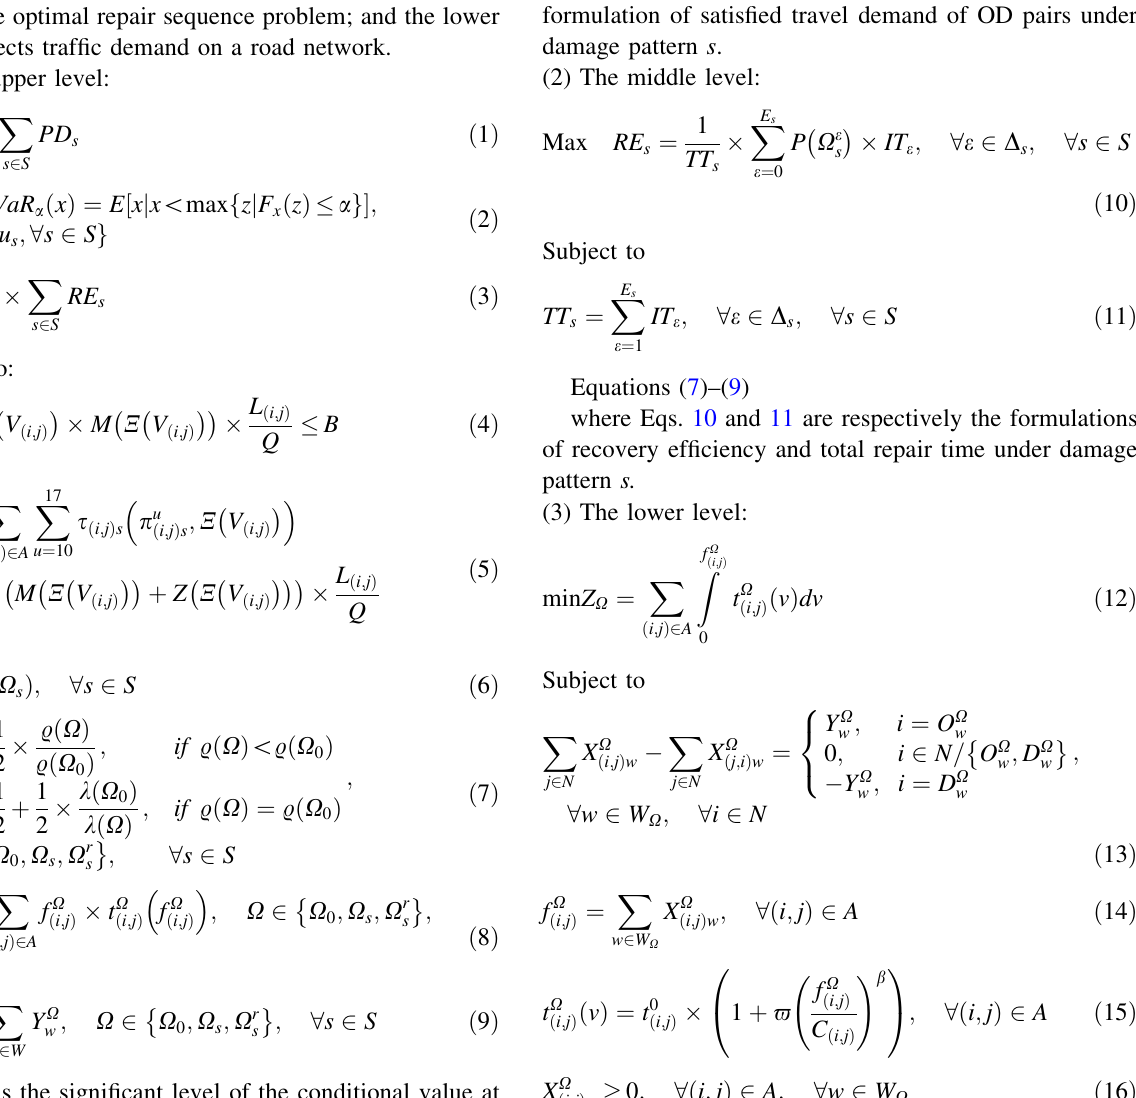
where the constant parameter - is 0.15 and b is 4. The lower level of the model was used in three scenarios: (1) intact road network; (2) damaged road network; and (3) partially repaired road network. Only the travel demand between the connected OD pairs is considered in the model. With reference to the traffic assignment models provided by Patriksson (2015), and with the premise of satisfying symmetry of the cost function, the objective function of user equilibrium, minimizing the individual user’s travel time, can be converted into Eq. 12. Equa- tion 13 calculates the traffic flow balance. Equation 14 means that the traffic flow of arc ( i , j ) is the sum of any OD pairs’ traffic flow that pass through arc ( i , j ). Equation 15 is the BPR’s link performance function. Equation 16 states that the traffic flow of any arc should be